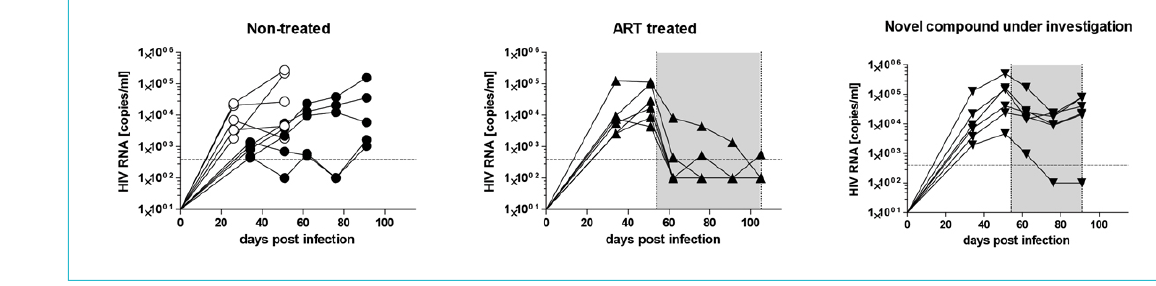
Figure 7: Humanised mice are highly susceptible to human immunodeficiency virus (HIV) and allow the examination investigational drugs. Humanised mice were infected with the CCR5-tropic HIV strain, YU-2, and viral load was monitored over time with quantitative real- time PCR. The left panel shows untreated mice. The middle panel shows mice treated with antiretroviral therapy (tenofovir, lamivudine and ral- tegravir). The right panel shows mice treated with an investigational compound. The grey shaded area indicates the treatment period. The filled and empty circles in the untreated group represent mice from two independent